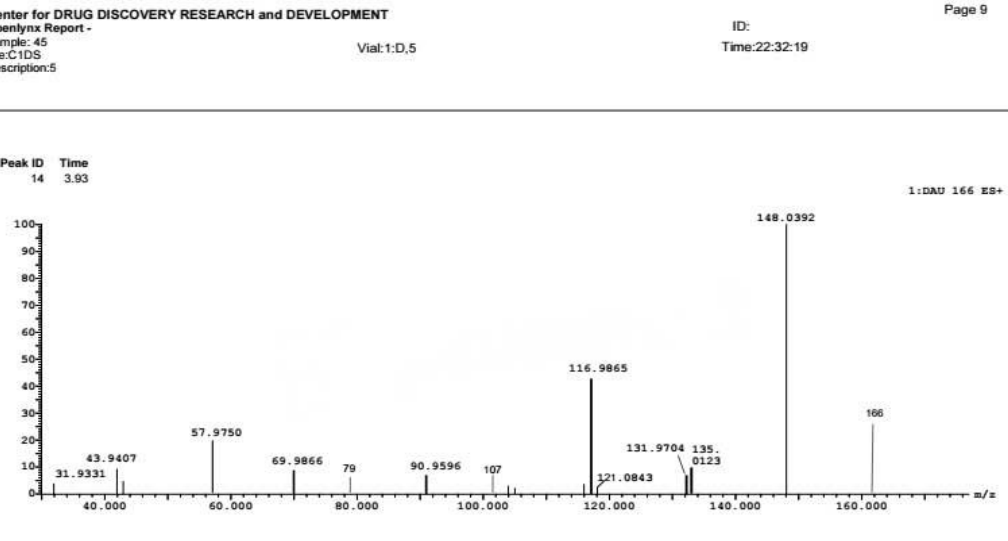
Figure 13. Mass fragmentations for isolated AS2 compound.